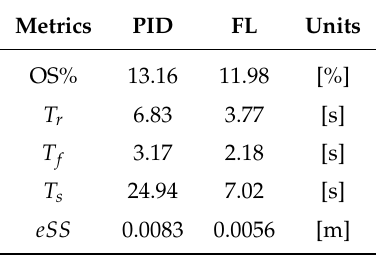
Table 2. Surge Time Response Results in Underwater Experiments for PID and FL